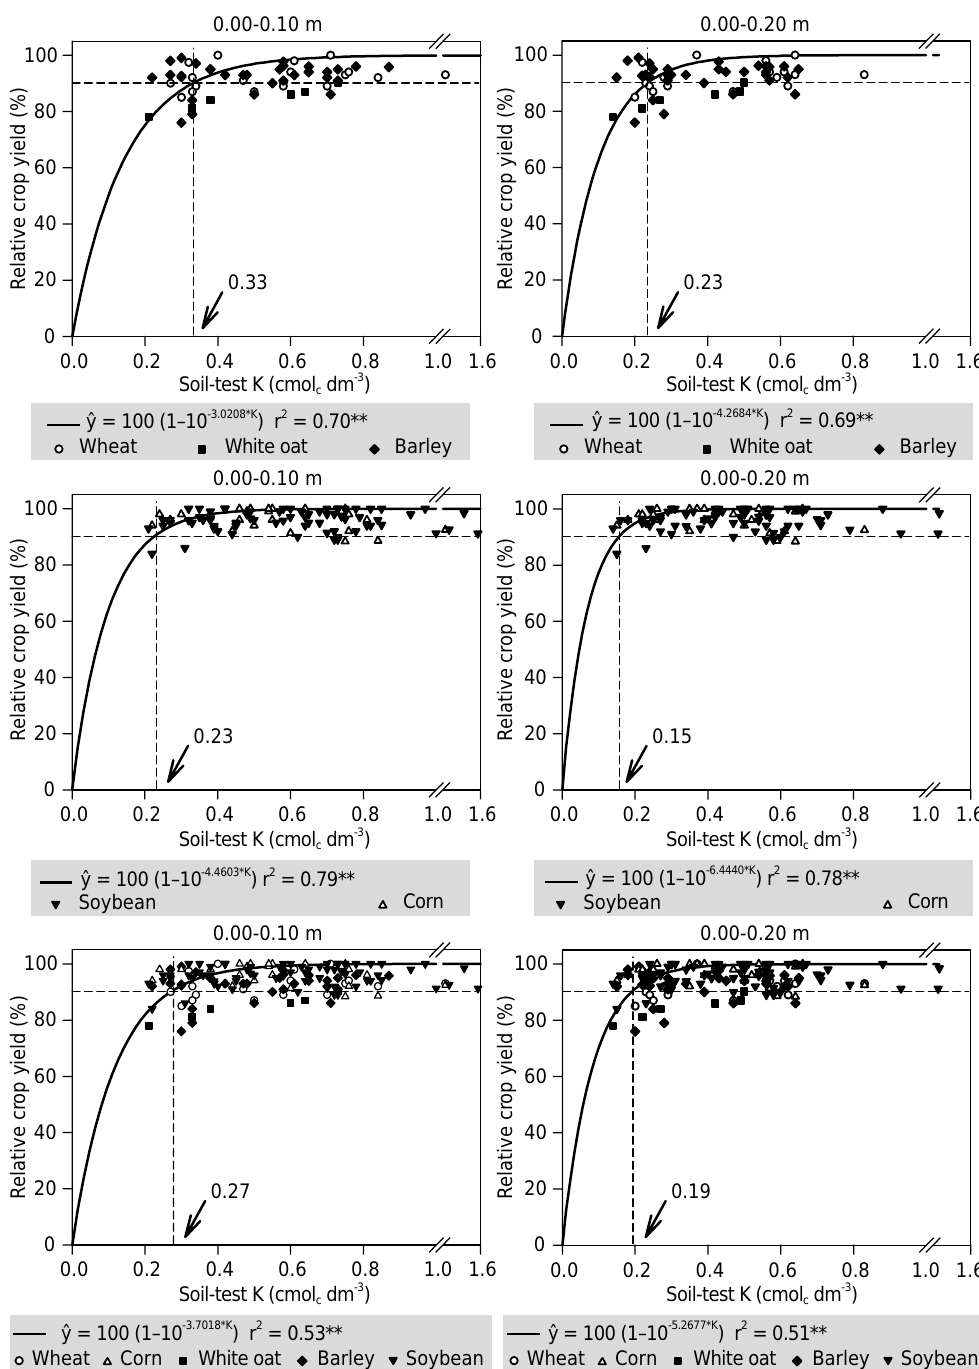
Figure 1. Relationship between soil-test K (Mehlich-1) in the 0.00-0.10 and 0.00-0.20 m layers and white oat, wheat, barley, soybean, and corn yields (0.01 cmol c dm -3 K equivalent to 3.91 mg dm -3 ). ** : significant